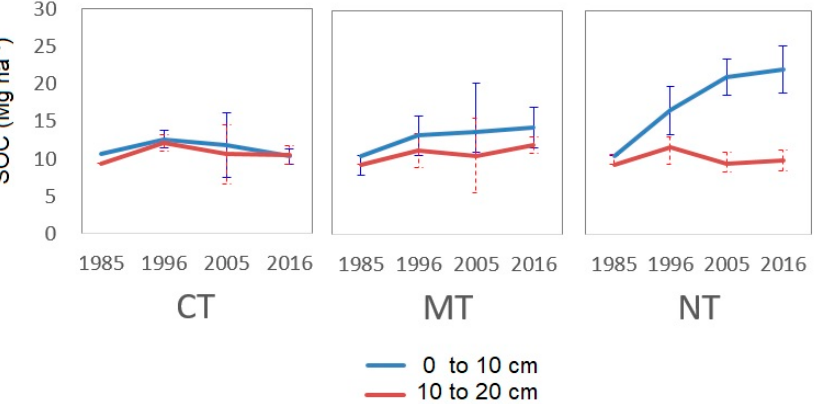
Figure 1. Soil organic carbon (Mg ha − 1 , in <2 mm air-dried soil) from 1985 to 2016, under different tillage practices. Historic data from 1984 to 2005 obtained from Hernanz et al. (2009). Data in 2016 are the average of n = 12. CT: conventional tillage, MT: minimum tillage and NT: no-tillage. Table 2. Stratification relationships (SR: contents at 0–10 cm/contents at 10–20 cm) of SOC, total nitrogen (N), and available phosphorus (P) and potassium (K) under different tillage types and crop rotations. Data obtained from the last two years of the